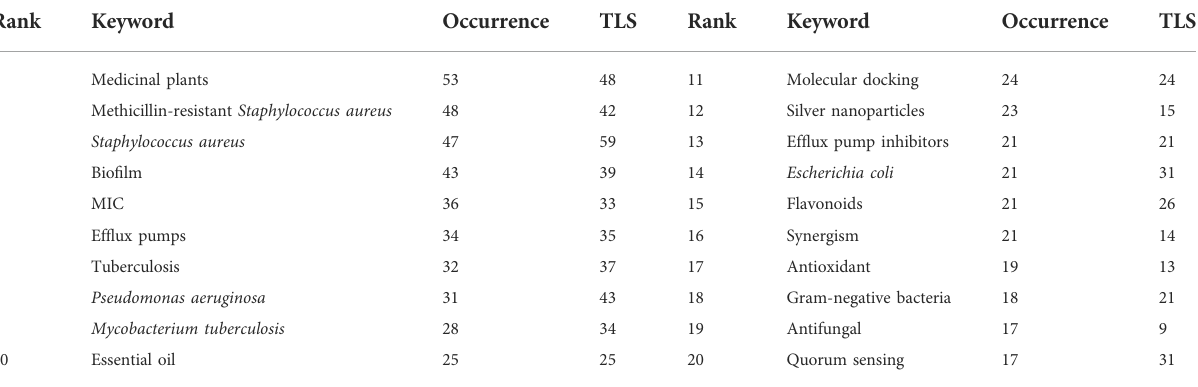
TABLE 5 The 20 most frequently occurring